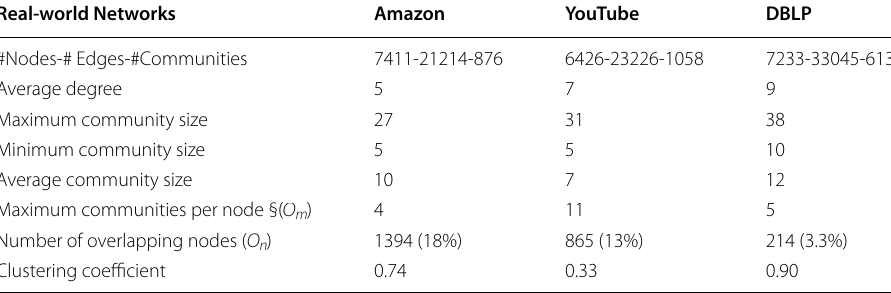
Table 2 Details of real-world